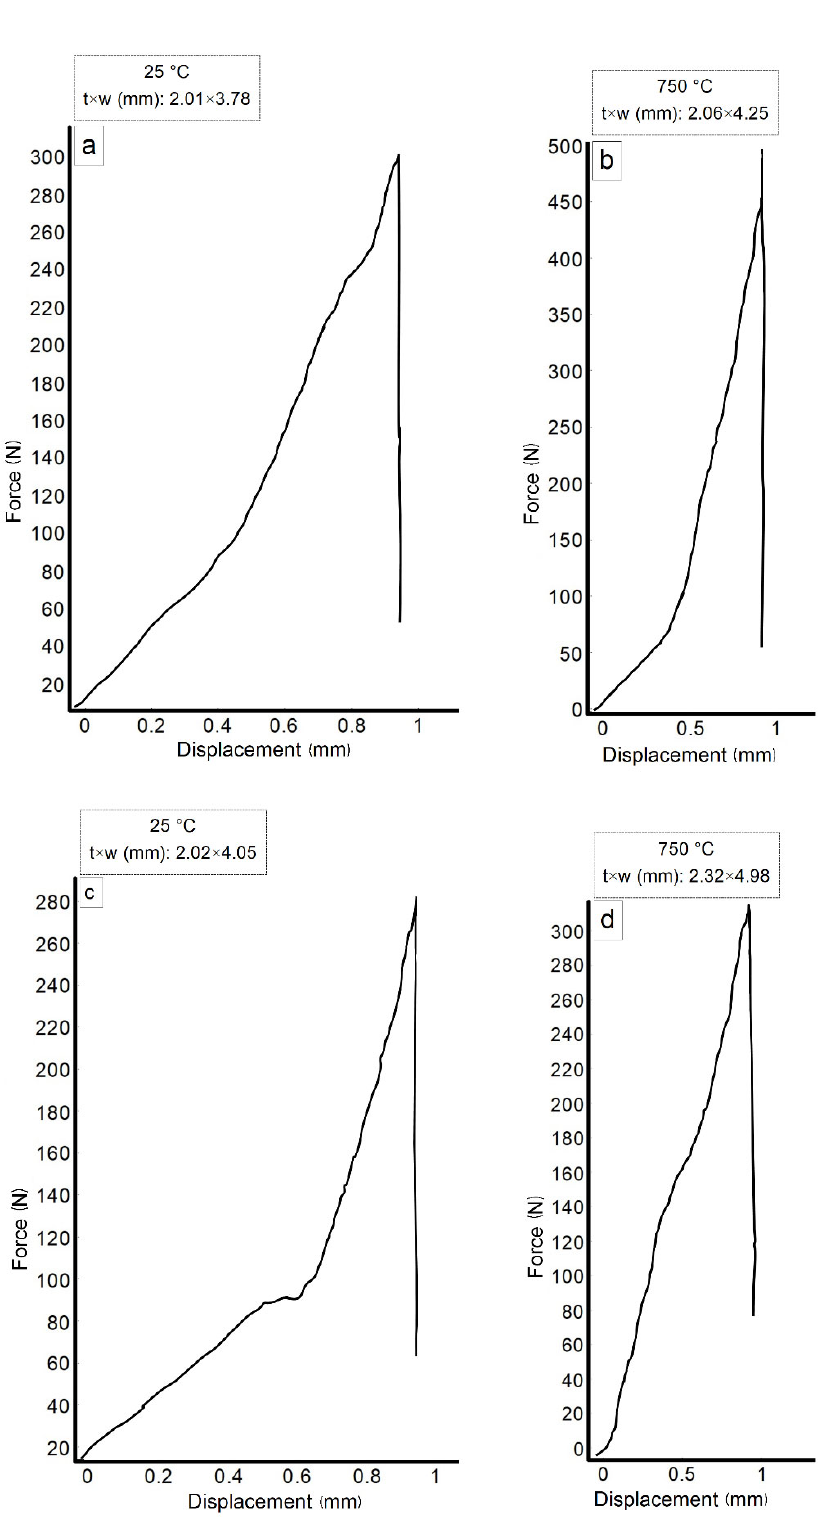
Figure 15. Force–displacement curves of pure matrix at 25 °C ( a ) and 750 °C ( b ) and matrix with 0.01 wt. % of ZrO 2 nanoparticles at 25 °C ( c ) and 750 °C ( d ); t—thickness, w—width, length in all cases 18 mm.